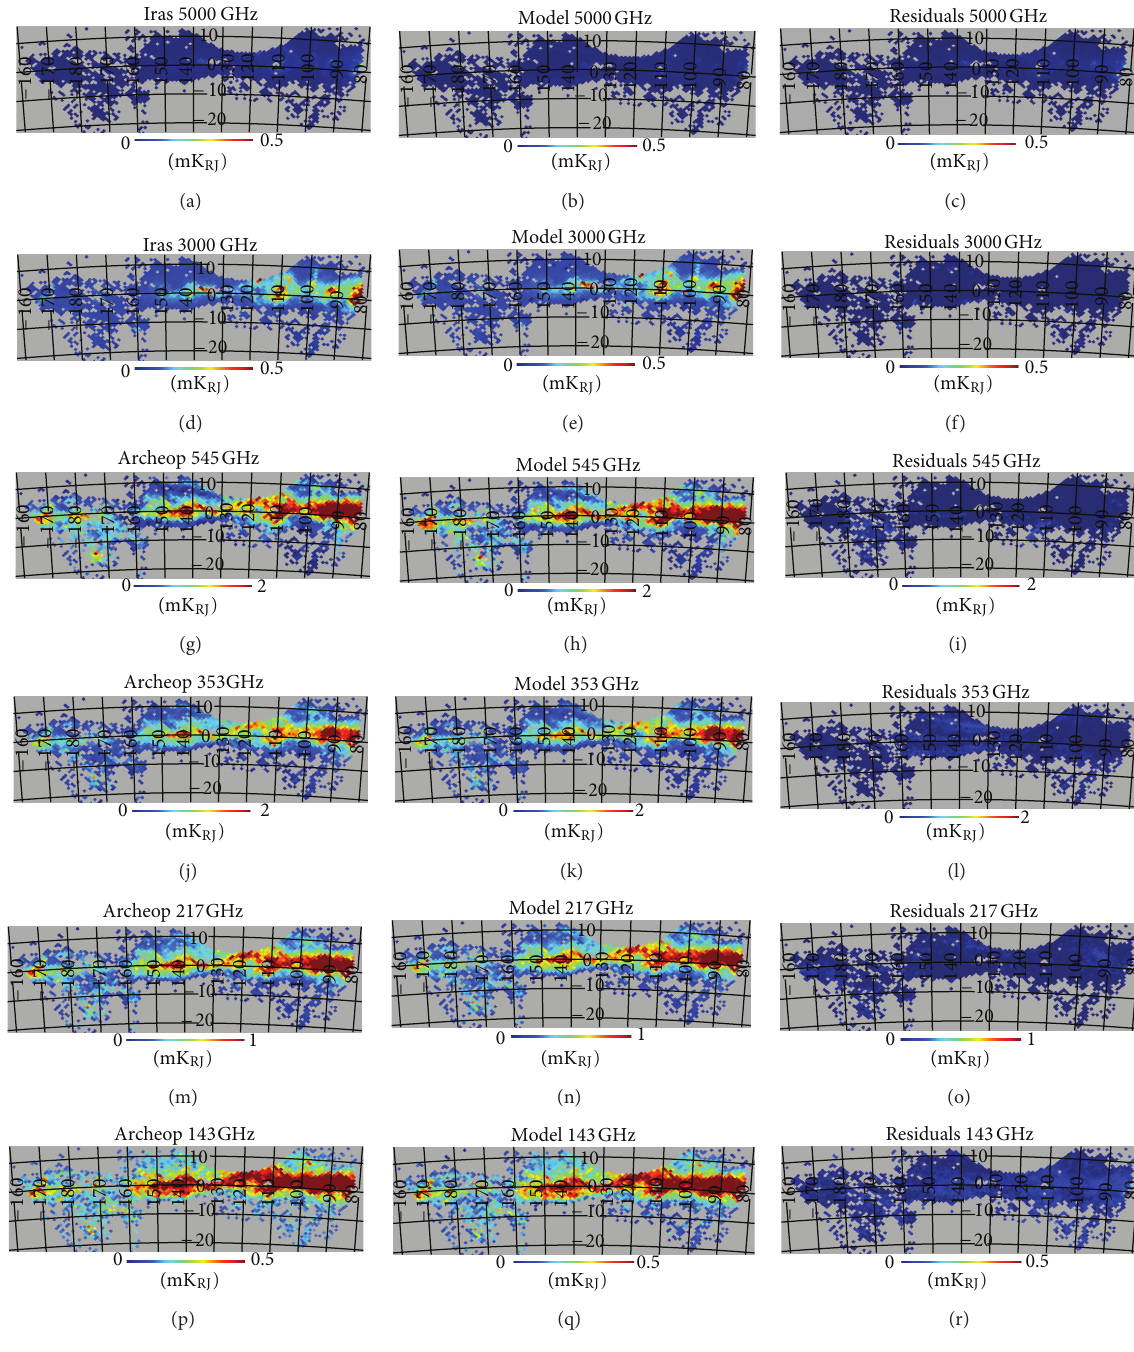
Figure 2: Temperature maps (mK ) for the ARCHEOPS data ( left ), the thermal dust emission model ( center ), and residuals ( right ). From RJ top to bottom, we present the 545, 353, 217, and 143 GHz